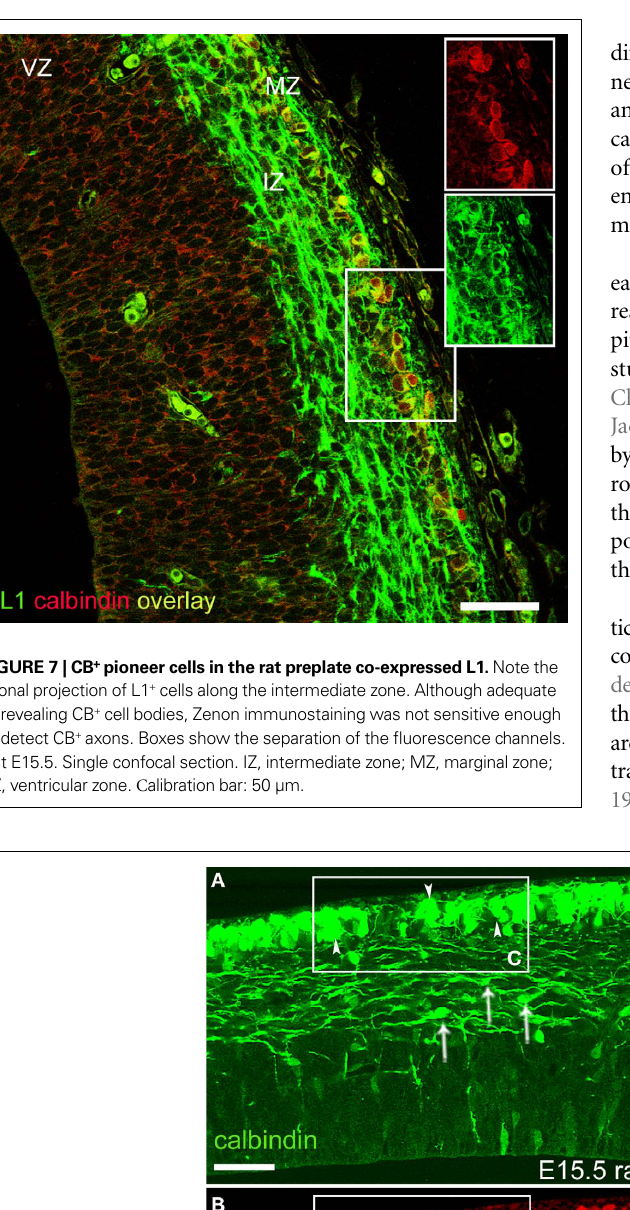
were Tbr1-negative. CB + cells in the ventricular zone (in A ) were also Tbr1-negative. (D) L1 + /Tbr1 + cells in the E12.5 mouse preplate. (E) TAG-1 + /Tbr1 + cells in the E12.5 mouse preplate. Single confocal sections. Calibration bar, 50 µm, in (A)